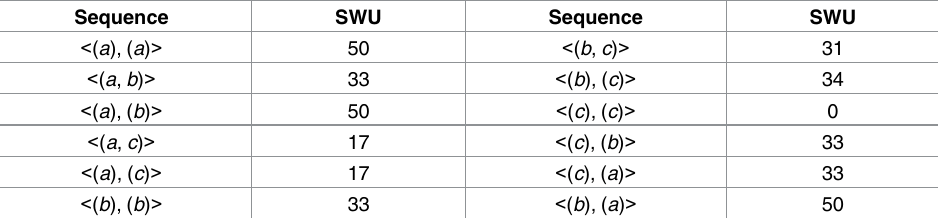
Table 4. The built SUS for the running